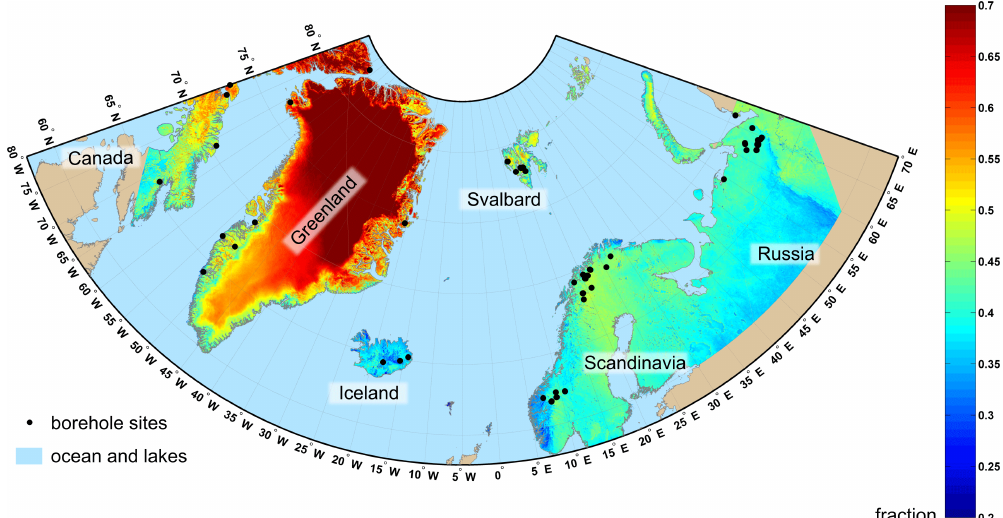
Figure 1. Fraction of MODIS LST measurements in the combined MODIS/ERA surface temperature product. Borehole sites from Interna- tional Permafrost Association (2010) used for validation of the modeled ground temperatures, note that a dot can represent several boreholes. Further boreholes outside the displayed regions are